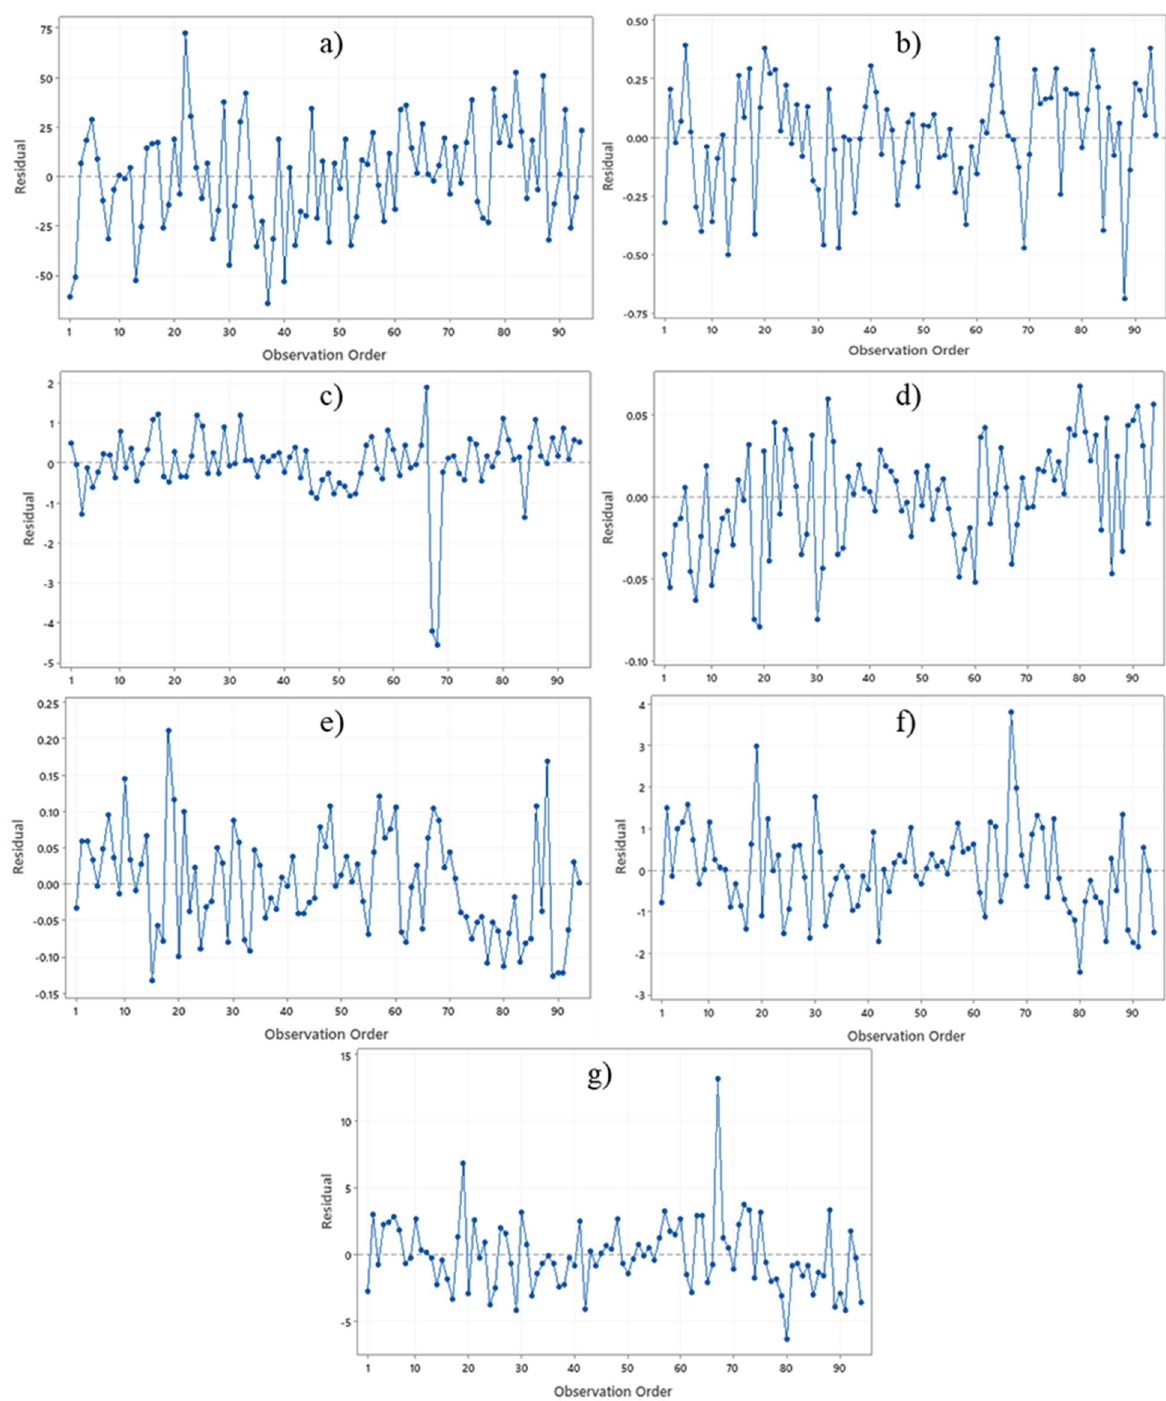
Figure 12. The residual plots of ( a ) UCS versus V p , ( b ) PLI(I s(50) ) versus V p , ( c ) I d2 versus V p , ( d ) γ n versus V p , ( e ) G s(C) , V p , (f) WA versus V p and ( g ) n versus V p